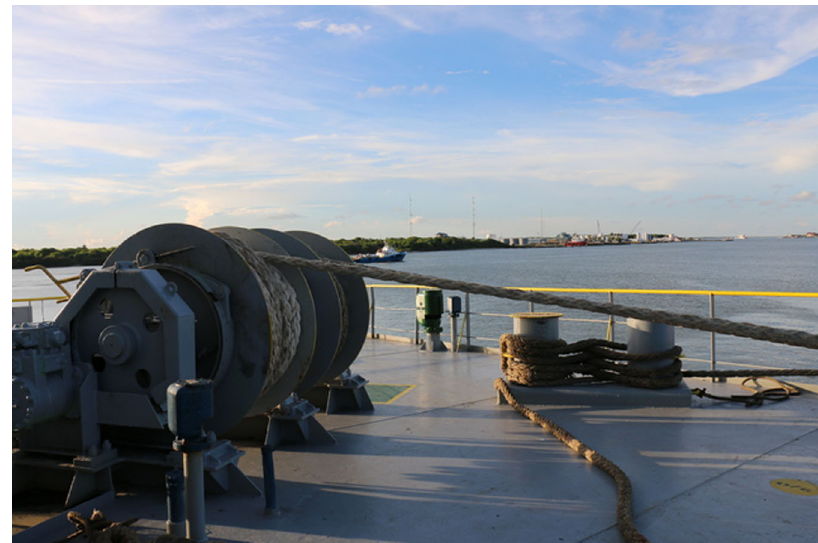
Fig. 1 Ropes on ship. Photograph taken by the author of the ropes described by a seafarer as dangerous.